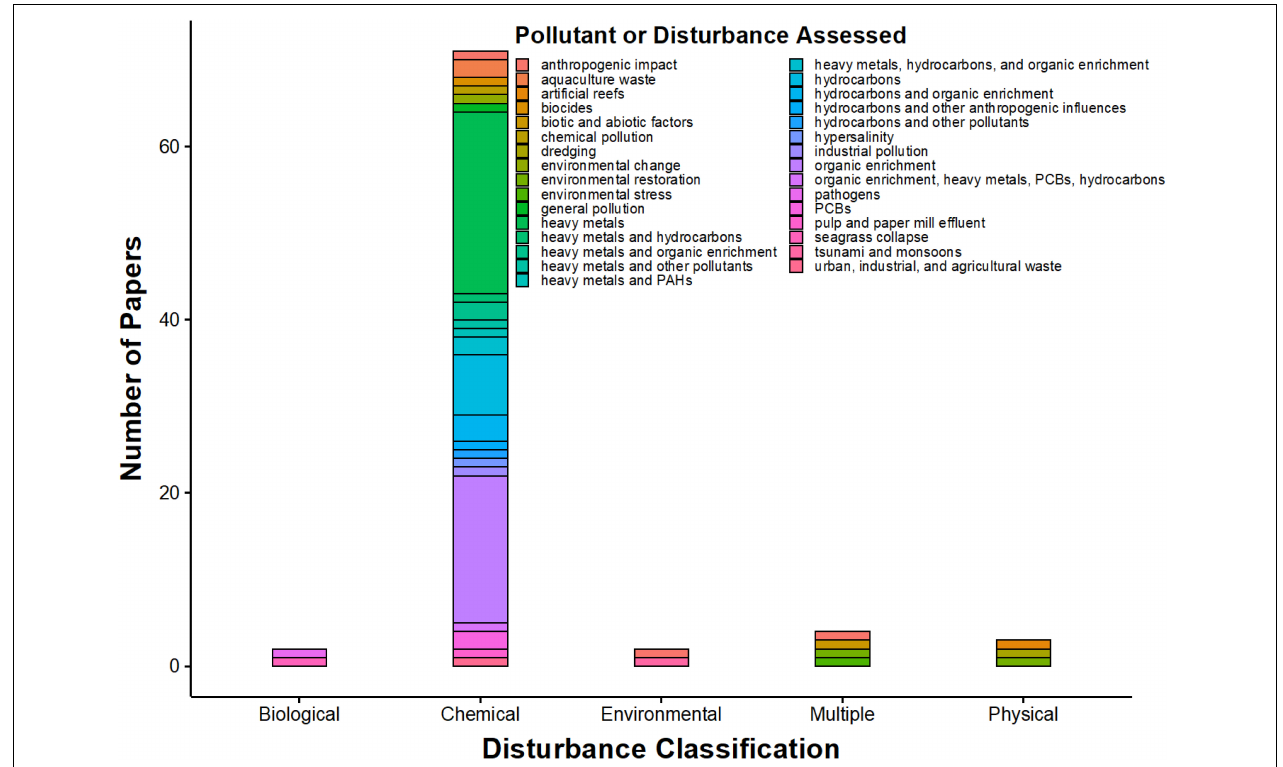
FIGURE 2 | Frequency of disturbance classifications and disturbances assessed in marine nematode bioindication literature from 1980-October 2020 based on an ISI Web of Knowledge search using the terms “marine AND nematod* AND bioindic*.” Papers were only considered if they explicitly featured nematodes as bioindicators or if they were reviews on nematode bioindication. Most of the papers addressed a combination of heavy metals and other pollutants as well as a combination of hydrocarbons and other pollutants.